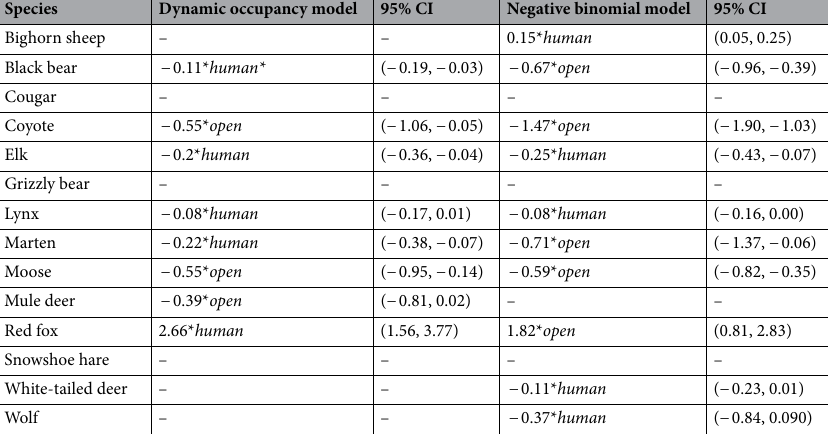
Table 3. The influence of human recreation on intensity of use of sites (i.e., the degree to which a camera site was repeatedly used by a species), based on two surrogate measures: detection probability from dynamic occupancy models and the total number of independent detections based on negative binomial mixed models. Results show beta parameters from the best-fitting model for the influence of either a categorical variable representing when the park was open vs closed to recreation (denoted ‘ open’ ; i.e., detection levels declined or increased equally across all cameras during the year open to recreation) or for a continuous variable representing the number of human detections at a camera (denoted ‘ human’ ; i.e., detections declined or increased more at cameras with a greater number of human triggers in the open year). Species with no human covariates in the best-fitting model (i.e., no response of intensity of use to recreation) shown with dashed line. *Beta parameter for dynamic occupancy models based on number of human triggers X